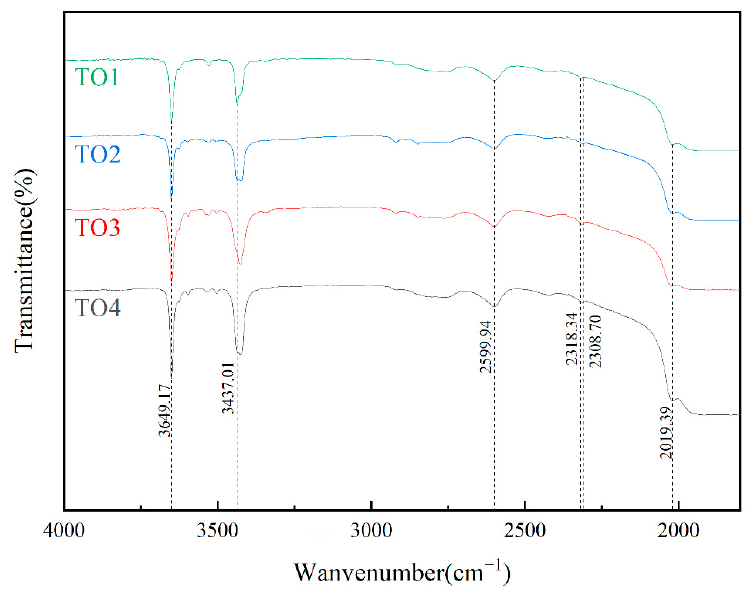
Figure 3. Infrared transmission spectra of yellow topaz samples (1800–4000 cm − 1 ).